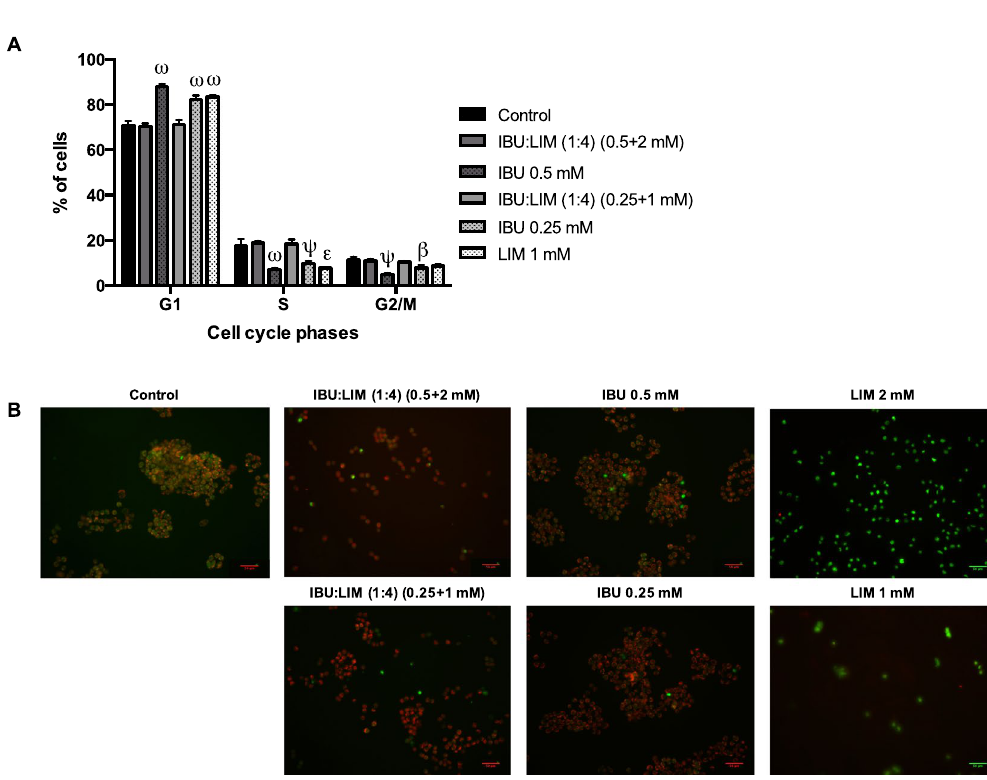
Figure 5. Effect of IBU:LIM (1:4), IBU and LIM in inducing cell cycle arrest and apoptosis on HT29 cells. Cell cycle analysis distribution on HT29 cells after incubation for 24 hours ( A ). Caspase-3 detection on HT29 cells treated during 24 hours. Active caspase-3 was detected by incubation with NucView488TM (apoptotic cells in green) and viable cells detected by incubation with MitoView633TM (cells with active mitochondria in red) ( B ). The scale bar is 50 μ m. Results are mean ± SD of four ( A ) and two ( B ) independent experiments performed in duplicated. Statistical significant differences are expressed in asterisks ( β = P ≤ 0.05, ε = P ≤ 0.01, ψ = P ≤ 0.001, ω = P ≤ 0.0001) by one-way ANOVA for multiple comparisons by Dunnett’s